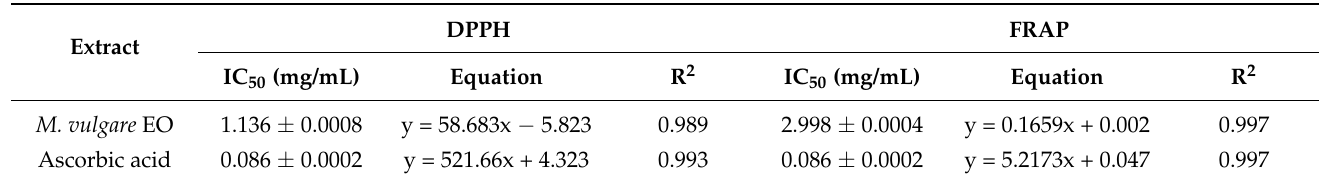
Table 3. The antioxidant power of M. vulgare essential oil represented by the inhibitory concentrations of the two antioxidant tests.